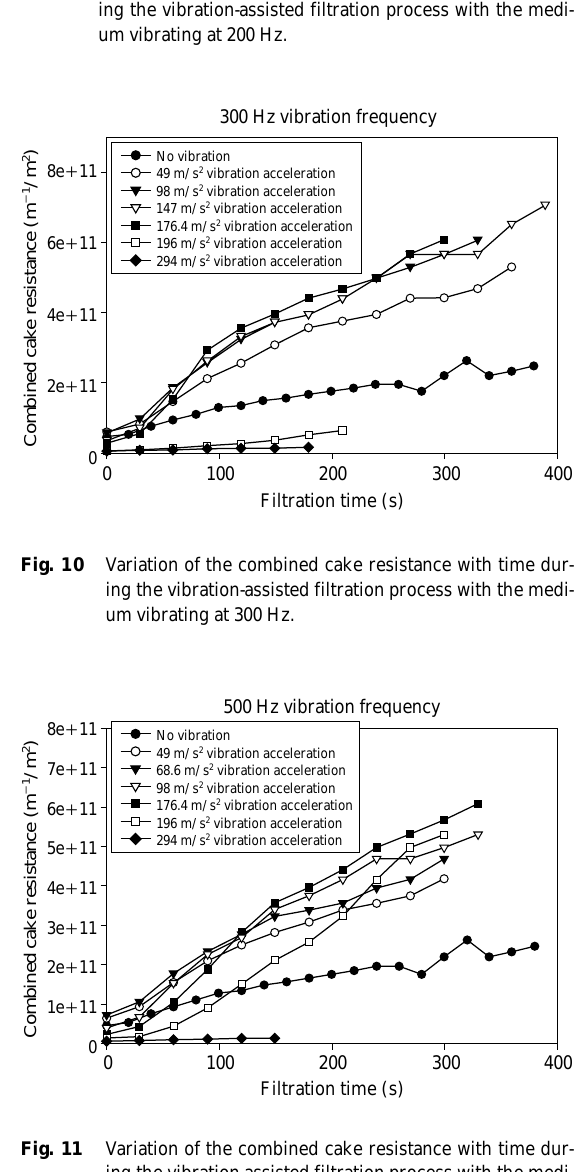
Fig. 11 Variation of the combined cake resistance with time dur- ing the vibration-assisted filtration process with the medi- um vibrating at 500